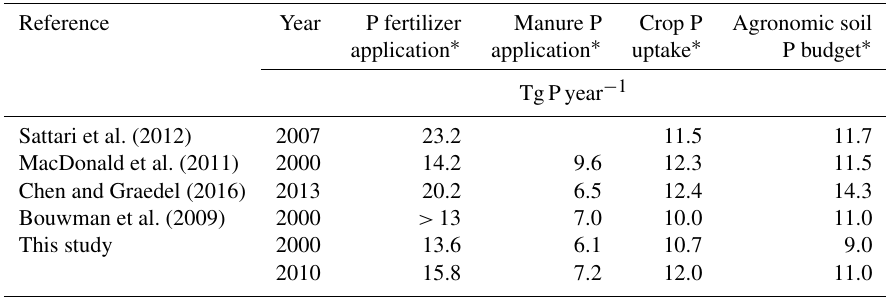
Table 5. Comparison with other studies for global cropland.